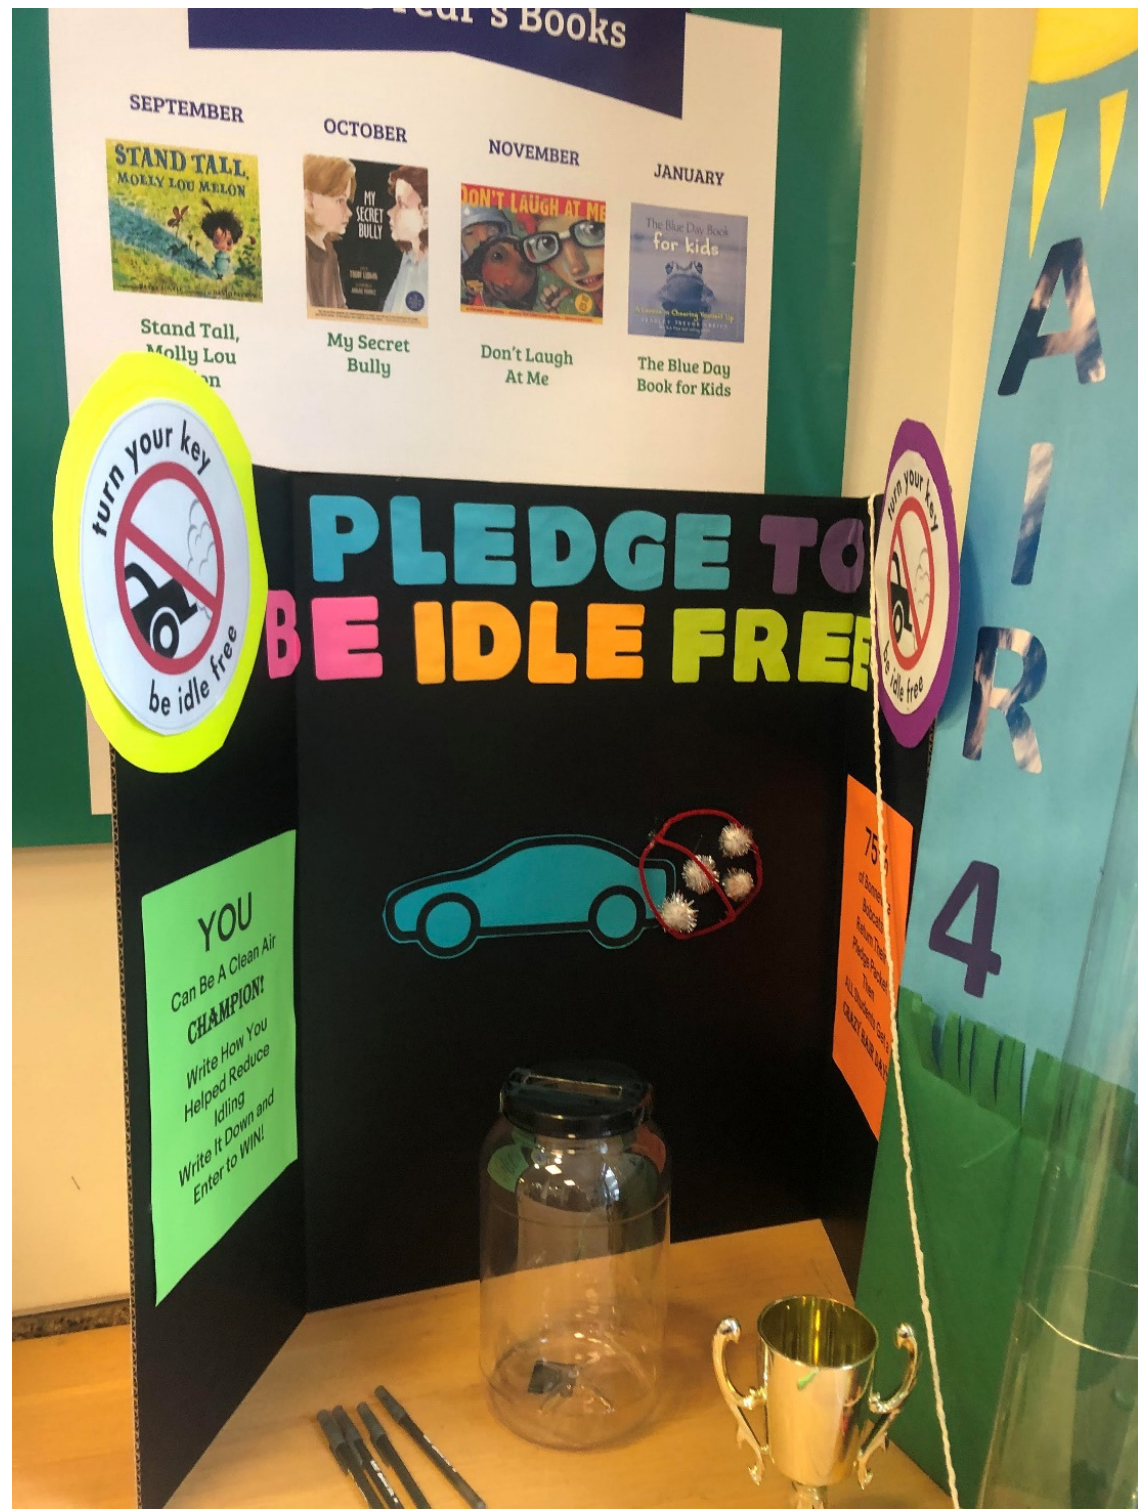
Figure A15. Clean air champion (CAC) display at school foyer.